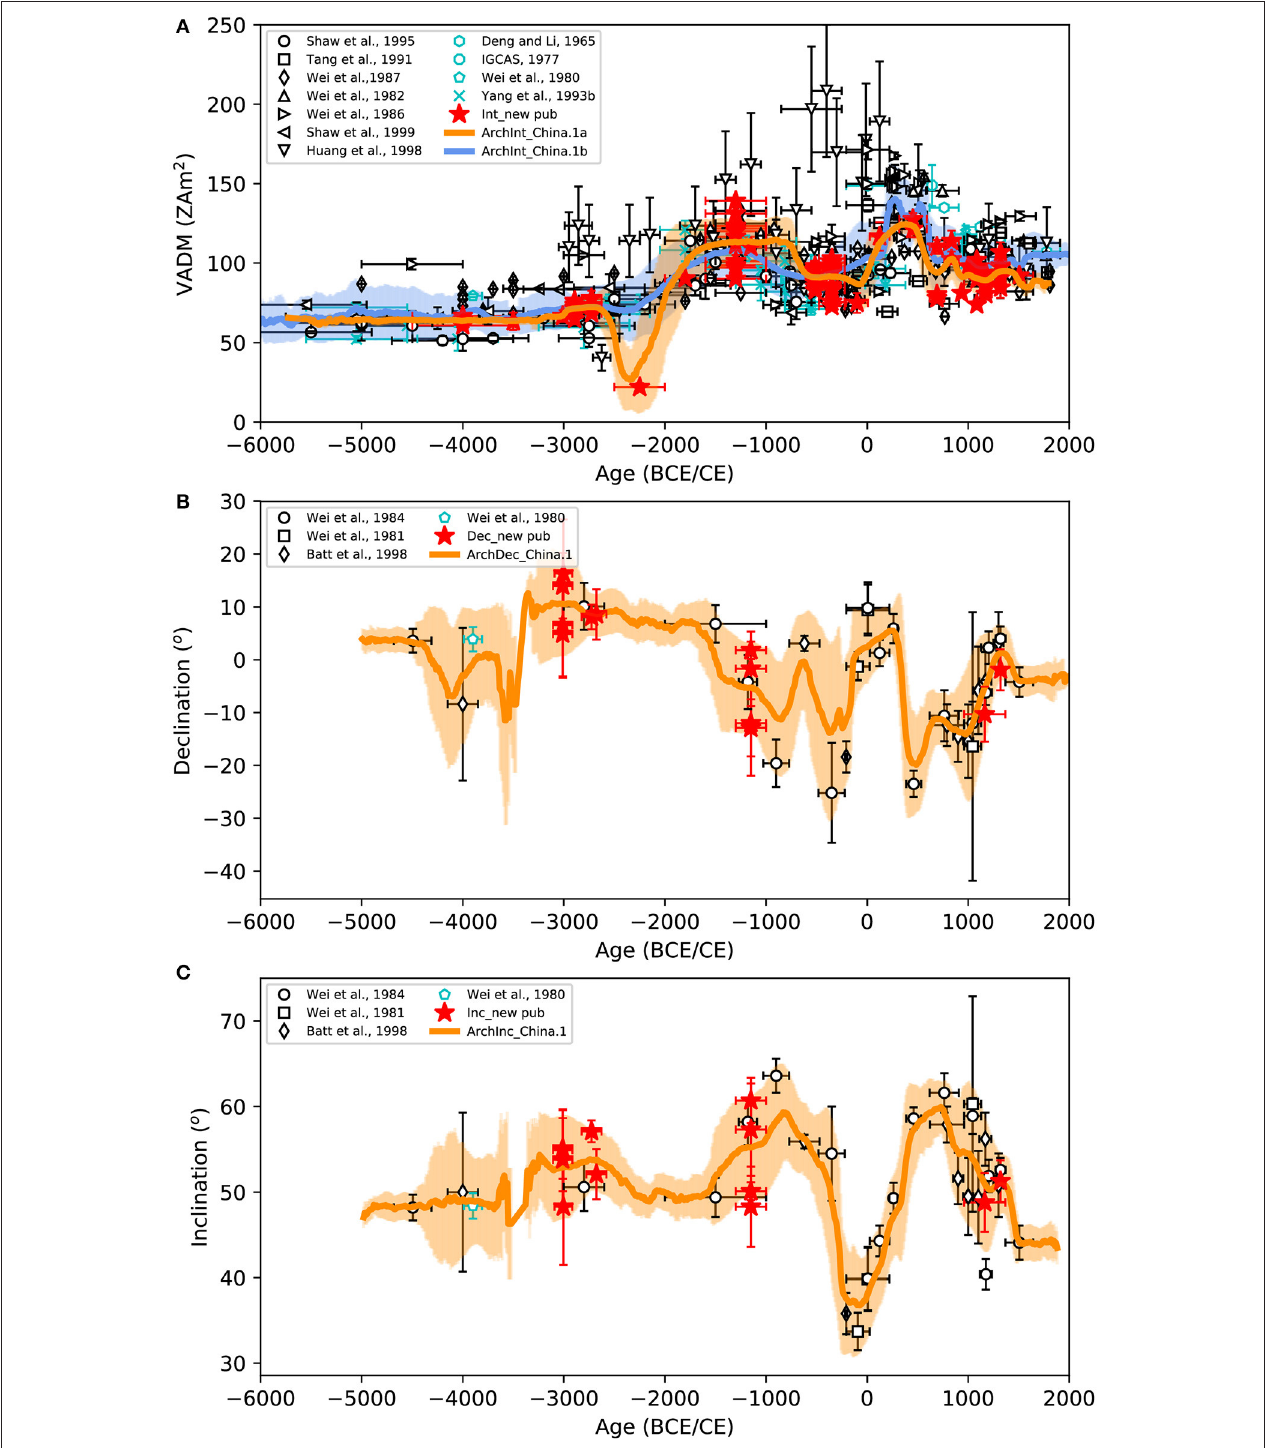
FIGURE 2 | Compilations of Chinese archeomagnetic data: (A) Virtual Axial Dipole Moment (VADM), (B) declination and (C) inclination. “Int_new pub” represents reanalyzed archeointensity data published by Cai et al. (2014, 2015, 2017). “Dec_new pub” and “Inc_new pub” represent directional data published by Cai et al. (2016). The shaded area of each curve represents the one standard deviation coverage interval. All the directional data were relocated to the center of China (35 ◦ N, 105 ◦ lE).